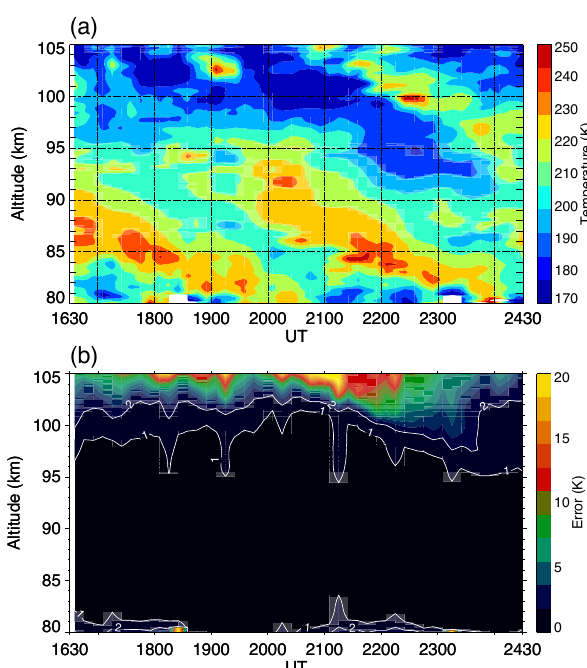
Figure 1. (a) The neutral temperature variation from 16:30UT on 29 October to 00:30UT on 30 October 2010. The warmer color indicates higher temperature and colder color indicates lower tem- perature. The original temporal and altitude resolution is 10min and 1.2km, respectively, and a 30min running average is applied. (b) The corresponding error values of the temperature.